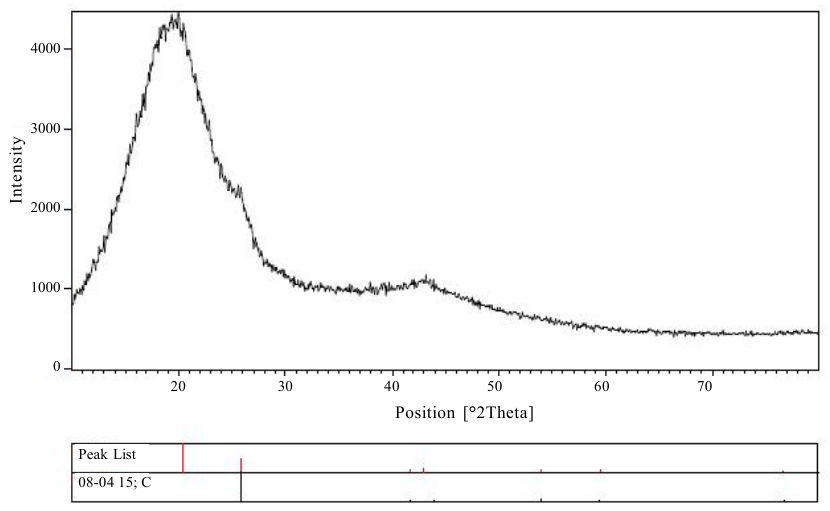
Fig. 5. XRD patterns of the CB/epoxy